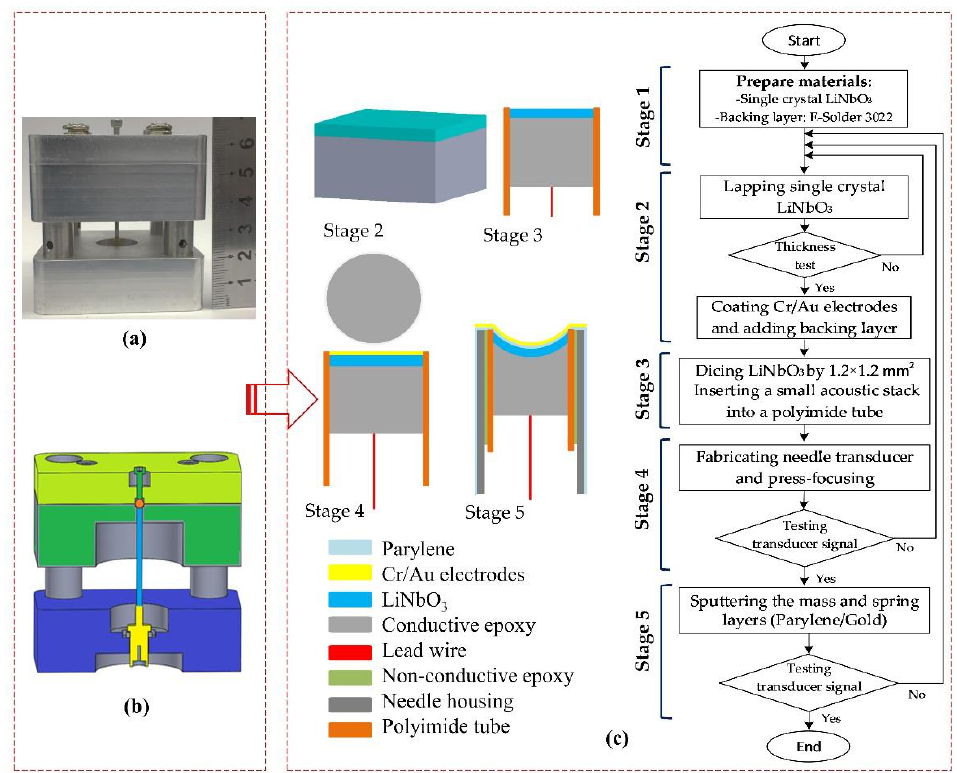
Figure 2. ( a ) A digital photograph of the press-fit system, ( b ) cross-sectional view of the press-fit system, and ( c ) the fabrication stages of press-focused needle transducer.